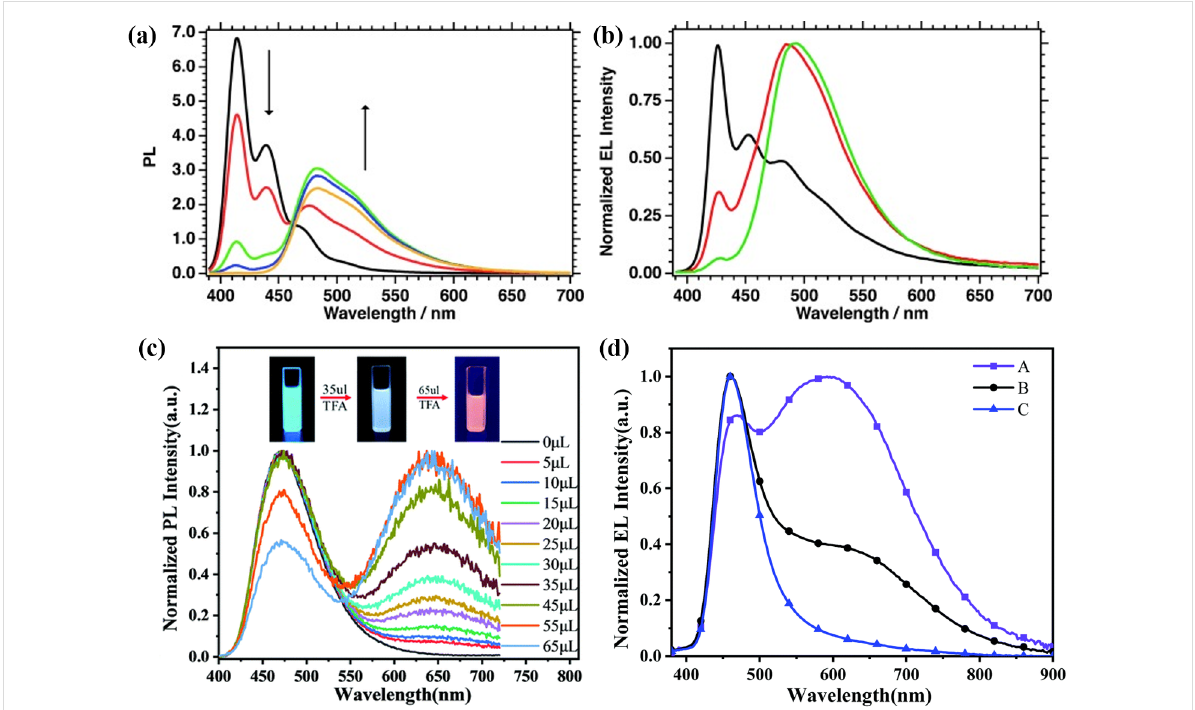
Figure 6: (a) PL spectra of compound 6 in toluene after addition of 0.0 (black line), 0.1 (red line), 0.3 (green line), 0.7 (blue line), 1.3 mol equiv (orange line) B(C 6 F 5 ) 3 . (b) EL spectra of the device with compound 6 at a constant current density of 111 mA cm − 2 for 0.00 (black line), 0.01 (red line), and 0.02 mol equiv (green) B(C 6 F 5 ) 3 . (c) PL spectra of compound 7 in solution containing different amounts of TFA under irradiation of UV light. (d) EL spectra of devices with different ratios of compound 7 and TFA; device A, compound 7 /TFA 50:1 (v/v); device B, compound 7 /TFA 5000:1